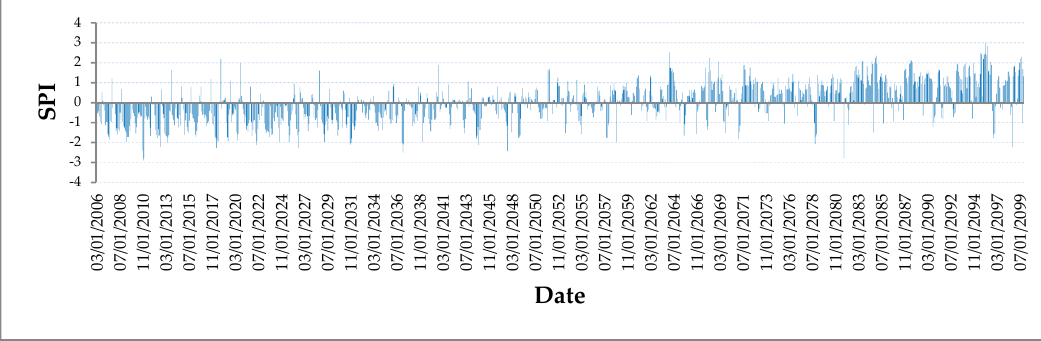
Figure 14. CanESM2 3-month period SPI values for Kaabong for the duration 2006 – 2099.